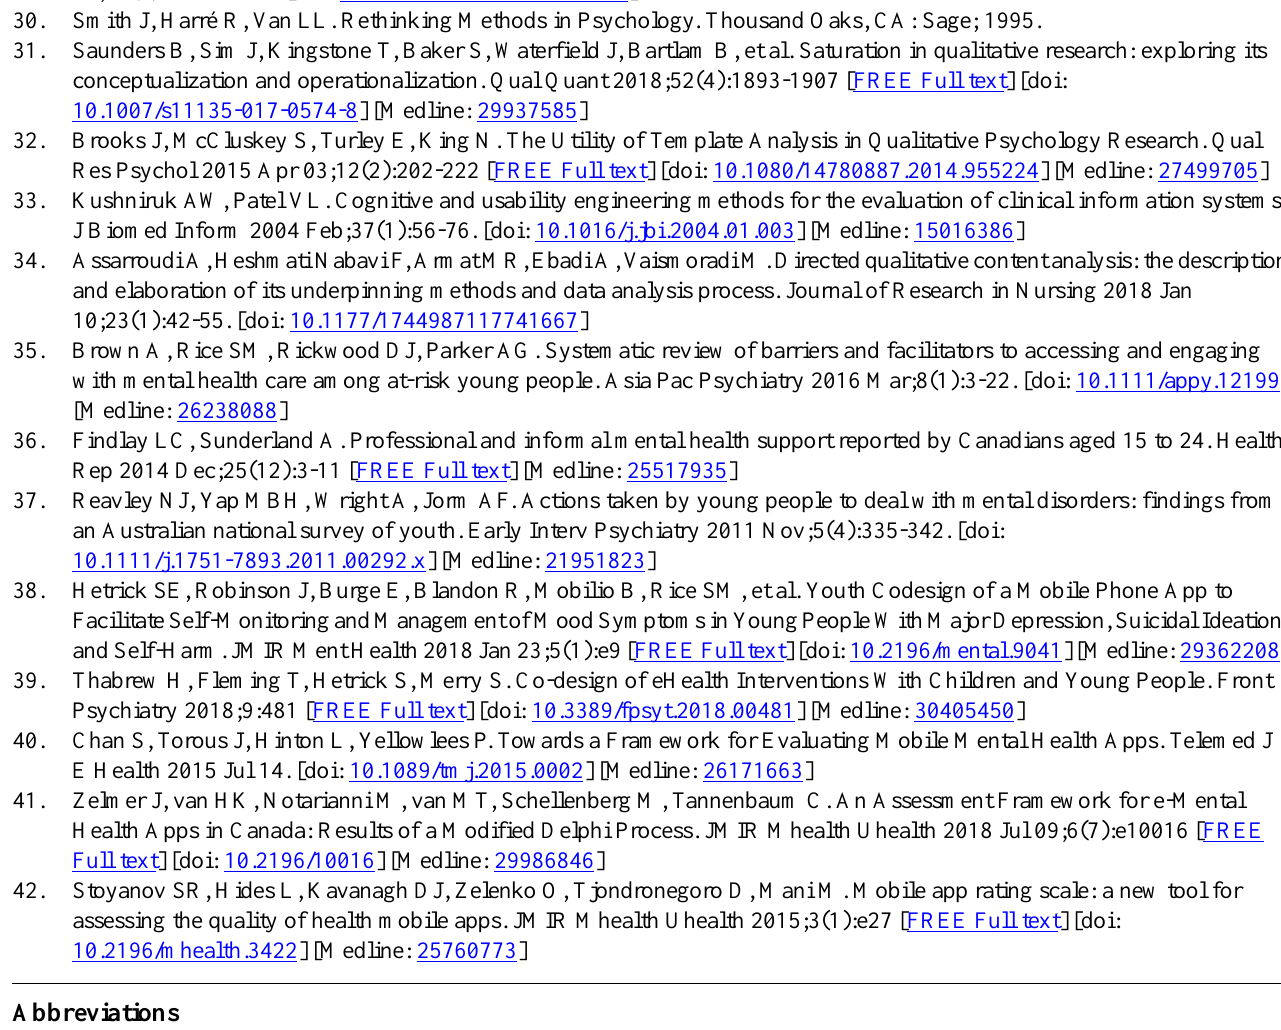
RCT: randomized controlled trial USE: Usefulness, Satisfaction, and Ease of